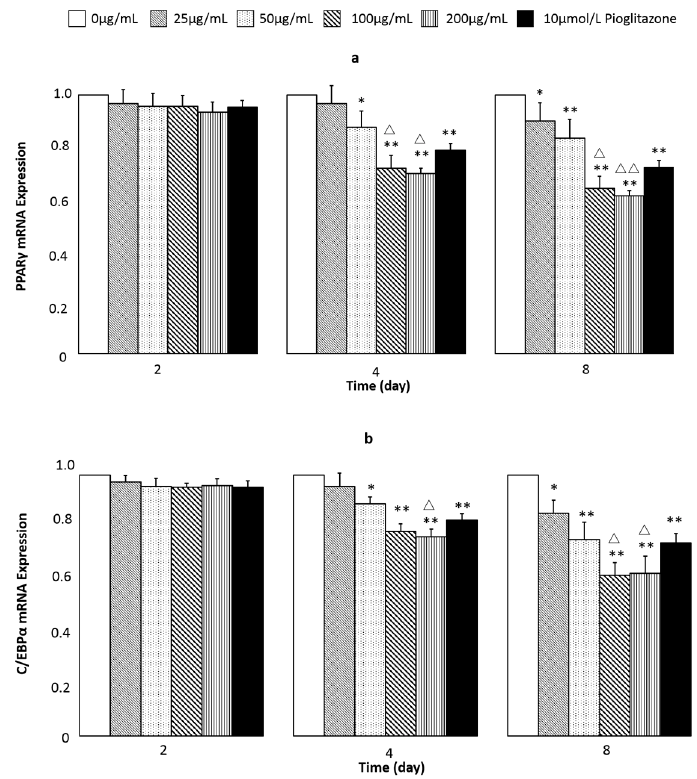
Figure 7. Effect of different concentrations of extracts on the mRNA expression of PPAR γ and C/EBP α in 3T3-L1 cells in the 2 days, 4 days and 8 days. The results were determined by RT-PCR. Data are represented as mean ± SD. n = 3. * p < 0.05, ** p < 0.01, compared with control. △ p < 0.05, △△ p < 0.01, compared with pioglitazone.